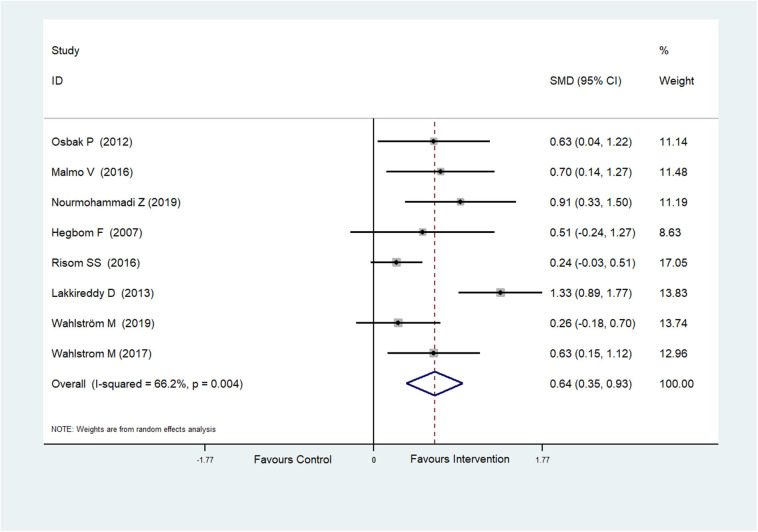
Forest plot shows the ES of physical exercise on General Health Perceptions in AF patients.